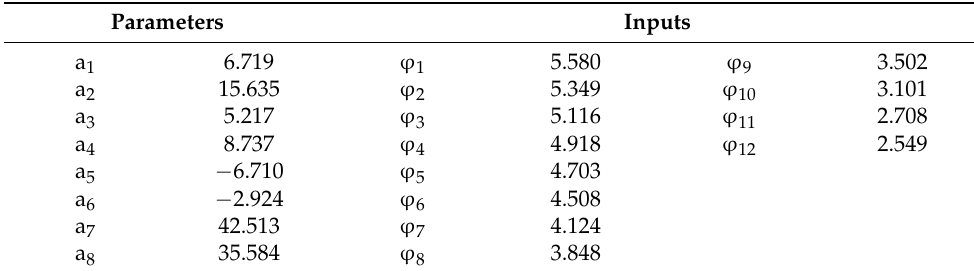
Table 4. Example 3: Optimum design parameters and inputs.